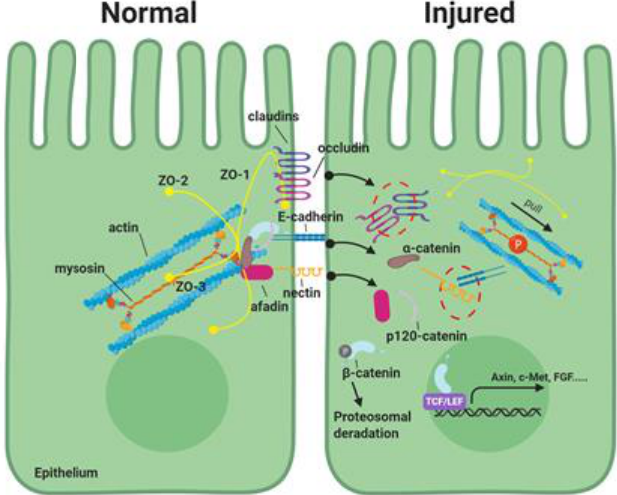
Figure 1. The role of phosphorylation of myosin light chain-2 (MLC-2) in the apical junctional complex in the intestinal epithelial paracellular pathway. The apical junctional complex consists of tight junctions (TJs) and adherens junctions (AJs). TJs consist of transmembrane proteins (e.g., claudins and occludin), and scaffold PDZ domain-expressing zonula occludin (ZO) proteins, which serve to form complex linking transmembrane proteins to the cytoskeletal actomyosin ring. AJs are located below the TJ and are comprised of two families of adhesive units: The E-cadherin/catenin family and nectin/afadin complexes. These proteins are dynamically regulated to maintain epithelial integrity. In intestinal disorders, increased phosphorylation of MLC-2 induces contraction of the perijunctional actomyosin ring and disrupt the apical junctional complex. This results in elevated paracellular permeability during the pathogenesis of various digestive diseases.